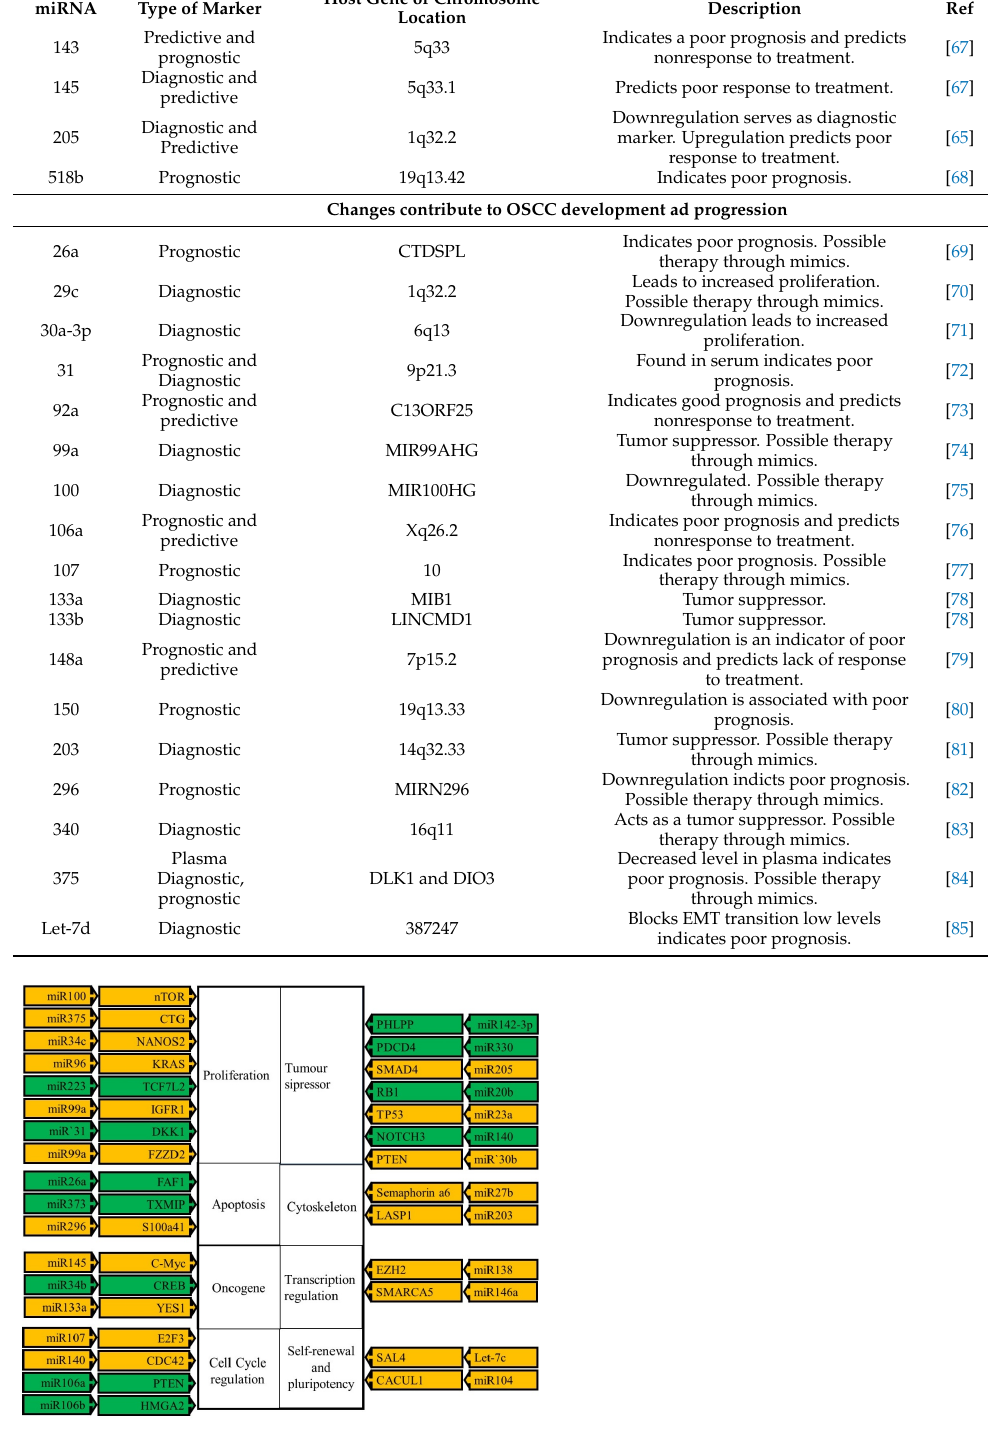
Figure 3. The targets of miRNAs with altered transcript levels in OSCC. The miRNAs are in the outer block arrow pointing towards the gene they target for translational regulation. The hallmark of cancer these genes are involved in is represented by the large blocks in the center of the figure. The miRNAs either affect the expression of this gene positively or negatively thereby contributing to OSCC development and progression. The miRNA gene blocks in orange signify that the miRNA acts as a tumor suppressor inhibiting the cancer process in the indicated block, while those marked in green act as oncogenes, enhancing the cancer activity indicated in the block [21,44,45,48,60,61,63,76,83,86]. 5. Alternative Splicing Alternative splicing is a tightly regulated process that involves the production of a variety of alternatively spliced transcripts that allows for the expression of multiple protein isoforms from a single gene. Therefore, alternative splicing increases the protein diversity and increases the catalog of proteins encoded for by the same number of genes [87]. Approximately 94% of all human genes contain introns that are alternately spliced. Alternative splicing and its dysregulation have been reported to play a role in the development and progression of OSCC [88]. This is due to the numerous pathologies being caused by dysregulated splicing. The ability of alternate splicing to contribute to development and progression of cancer is due to splicing promoting the loss of function of tumor suppressor genes or causing increased oncogene activity and the activation of pro-oncogenic pathways [89]. Splicing switches are also activated in tumors. This involves the splicing pathways favoring the splicing of mRNAs to form a pro-oncogenic isoform. These switches may favor isoforms that can promote the development of cancer by increasing growth and proliferation, invasion and metastasis and immune evasion. They can also contribute to the resistance of the cancer to drugs being used to treat it [89–92].